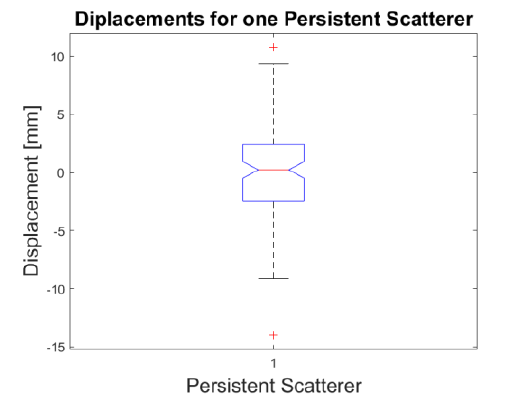
Figure 4. Example of a box